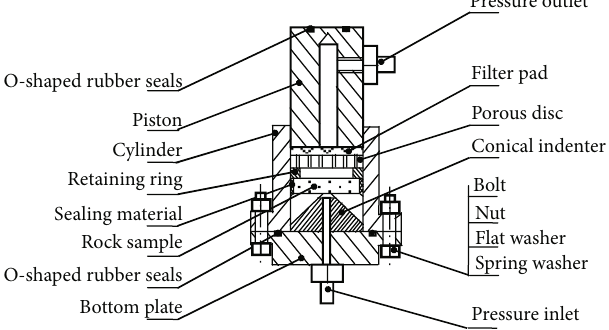
Figure 3: Schematic of the